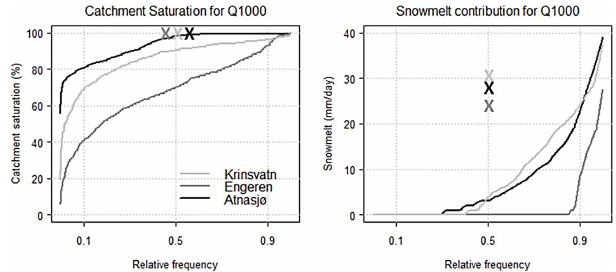
Figure 13. Distributions of catchment saturation conditions and snowmelt rates associated with the 10 4 simulated events producing a 1000-year discharge (Q1000) for the three catchments. The values simulated by HBV-DF for the event with the highest discharge are also indicated with